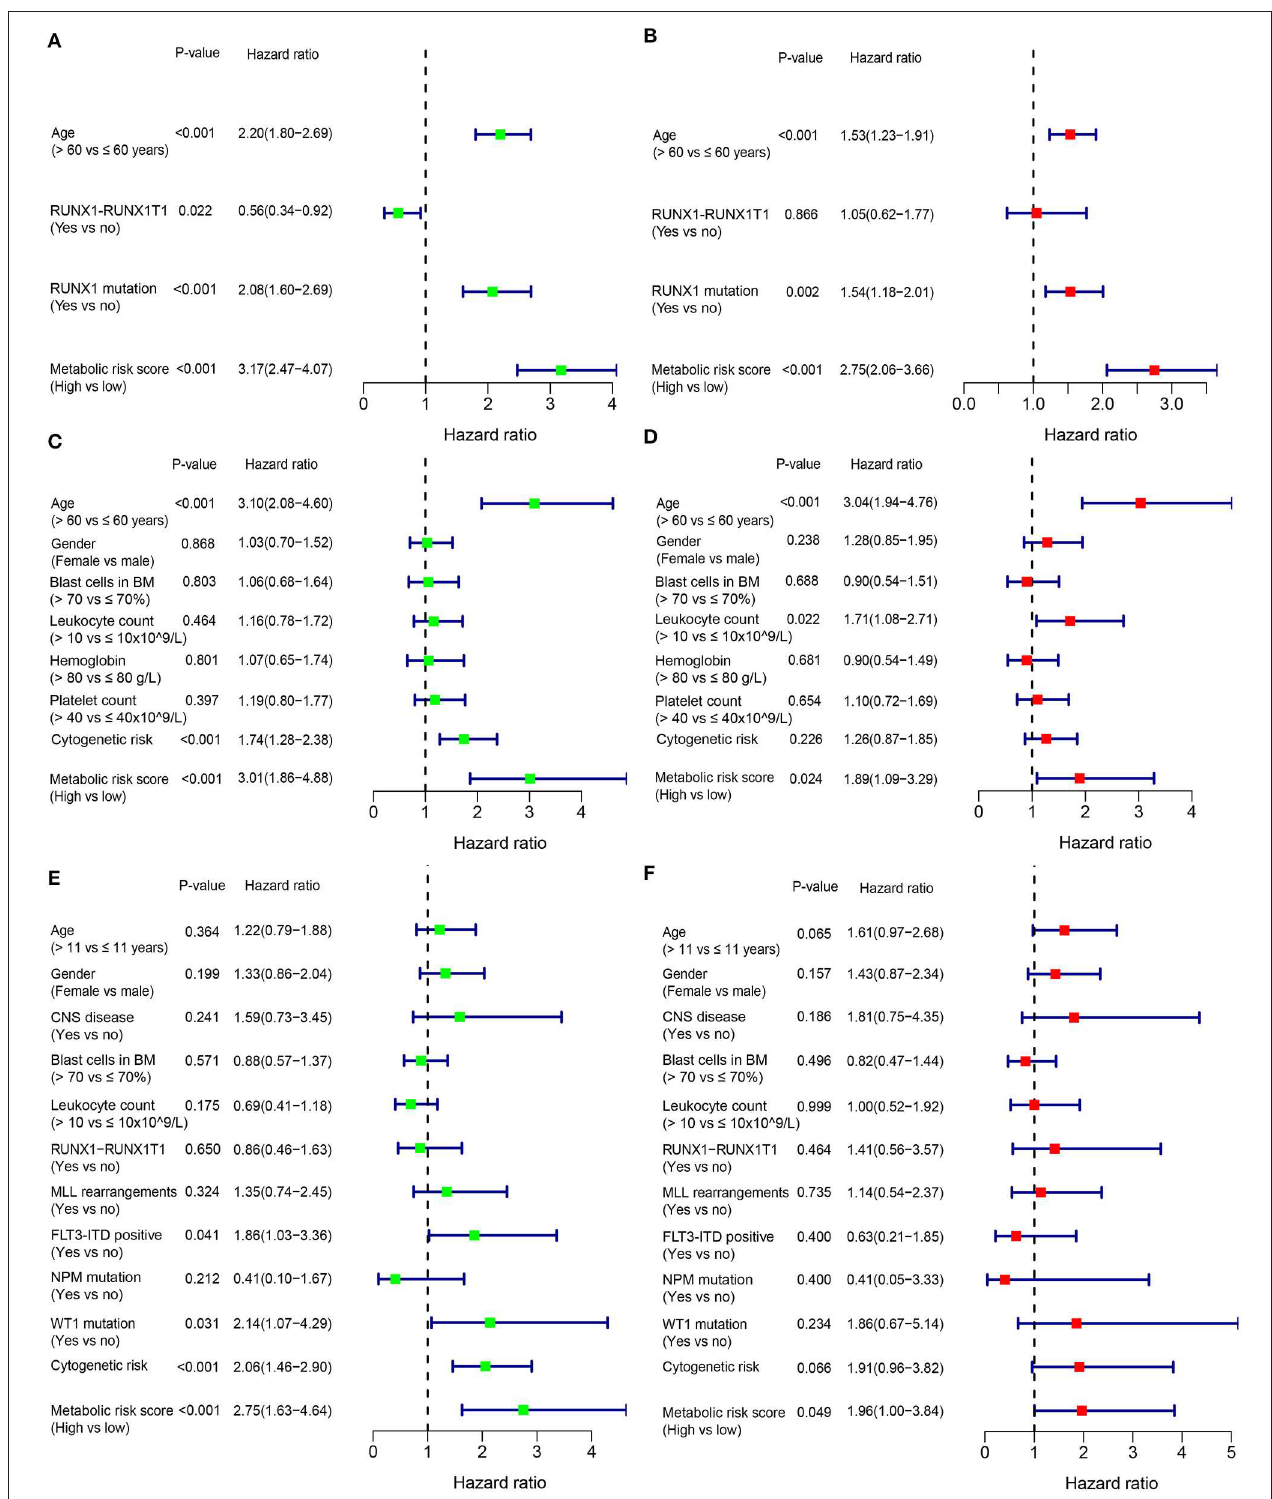
FIGURE 3 | Forest plot of the univariate (left) and multivariate (right) Cox regression analysis in the training cohort (A,B) , adult external cohort (C,D) , and pediatric external cohort (E,F) for acute myelogenous leukemia (AML). BM, bone marrow; CNS, central nervous system.